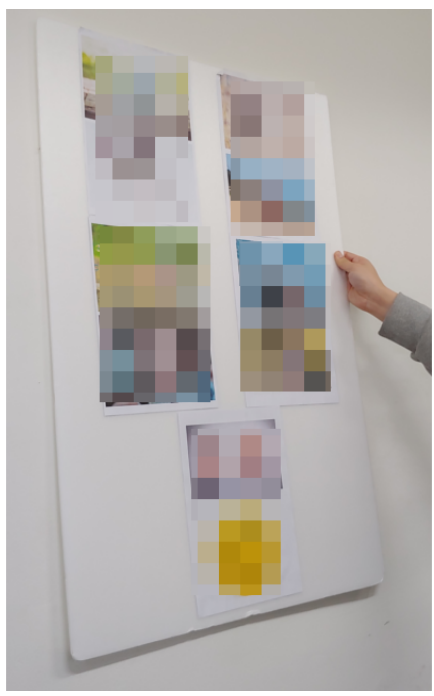
Figure 2. Image panel